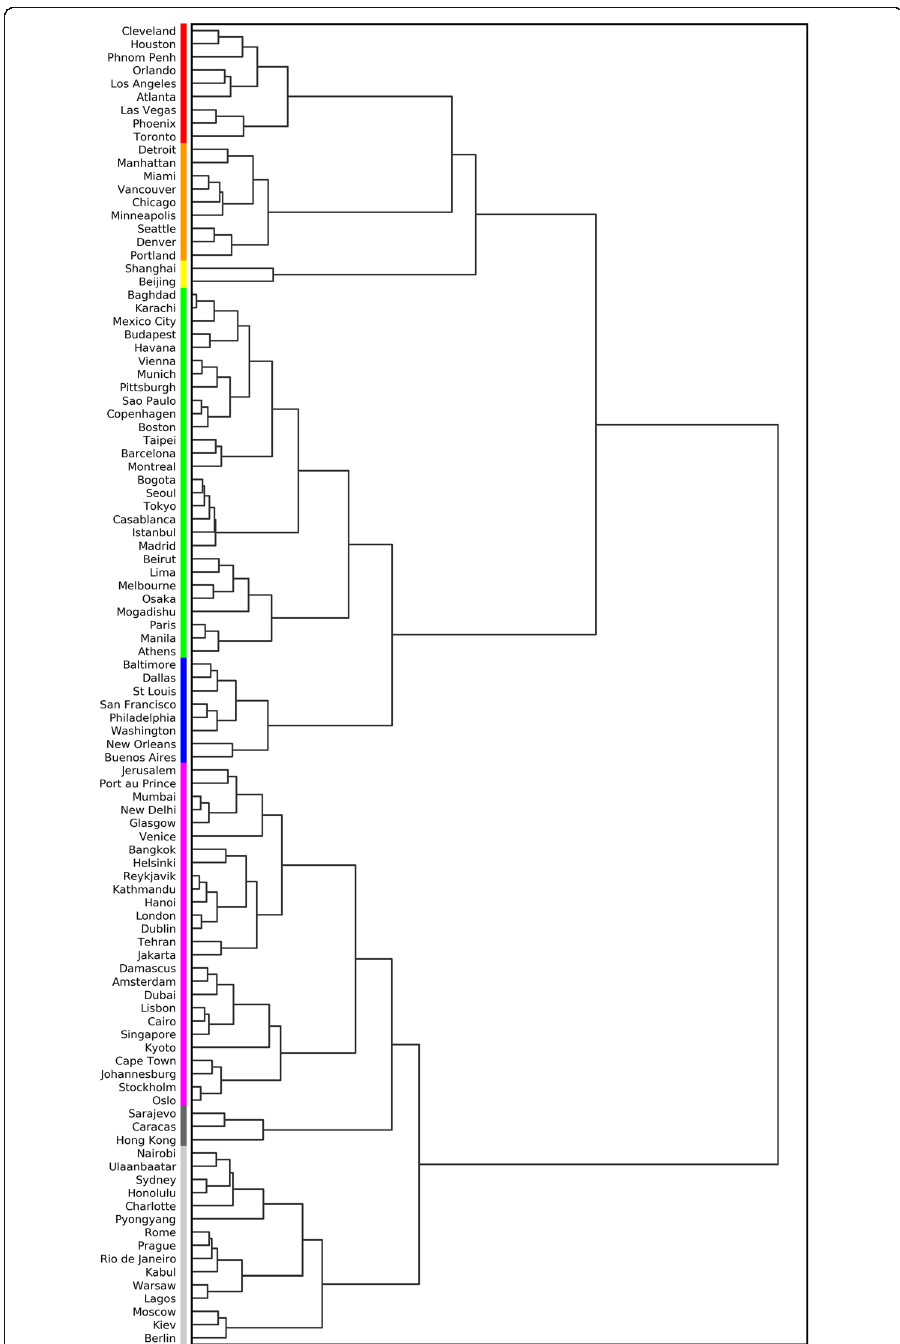
Fig. 6 Cluster analysis dendrogram. Cluster colors correspond to Fig.